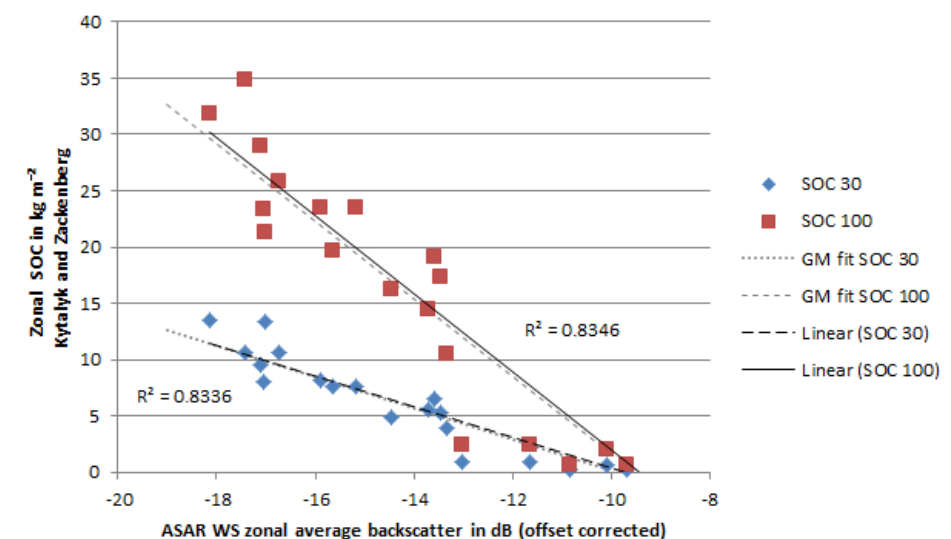
Figure 6. SOC for 30 and 100cm depths versus backscatter from ENVISAT ASAR WS (offset corrected) for Kytalyk and Zackenberg including function for linear fit of the GM data (see Fig. 4)